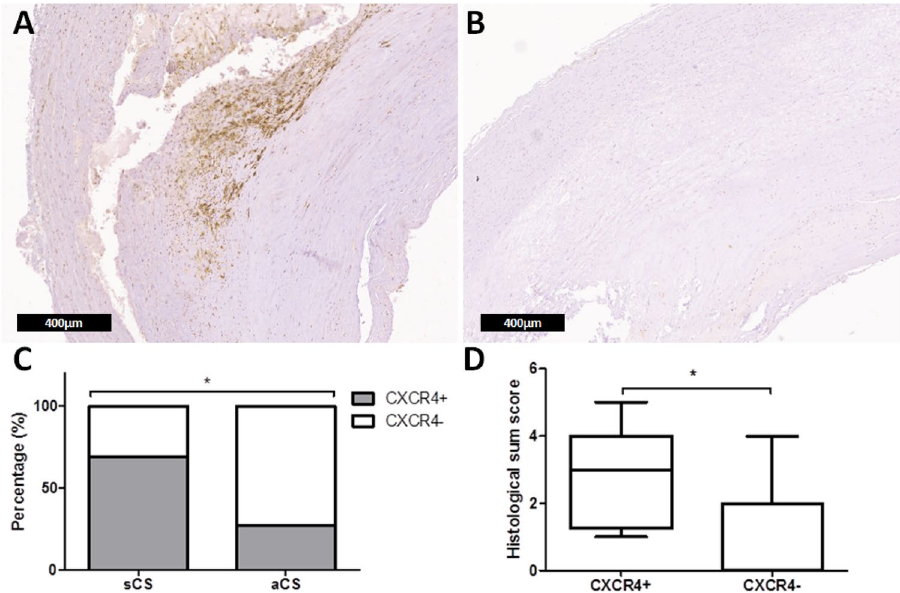
Figure 4. CXCR4-staining and relation to groups and criteria of plaque vulnerability. Exemplary CXCR4- staining of carotid plaque specimens of a sCS patient (scale bar: 400 µm) ( A ) and an aCS patient (scale bar: 400 µm) ( B ) indicating presence of CXCR4-positive inflammatory cell infiltrations in ( A ). Differential presence of CXCR4-positive inflammatory cells regarding groups ( C ) and histological sum score ( D